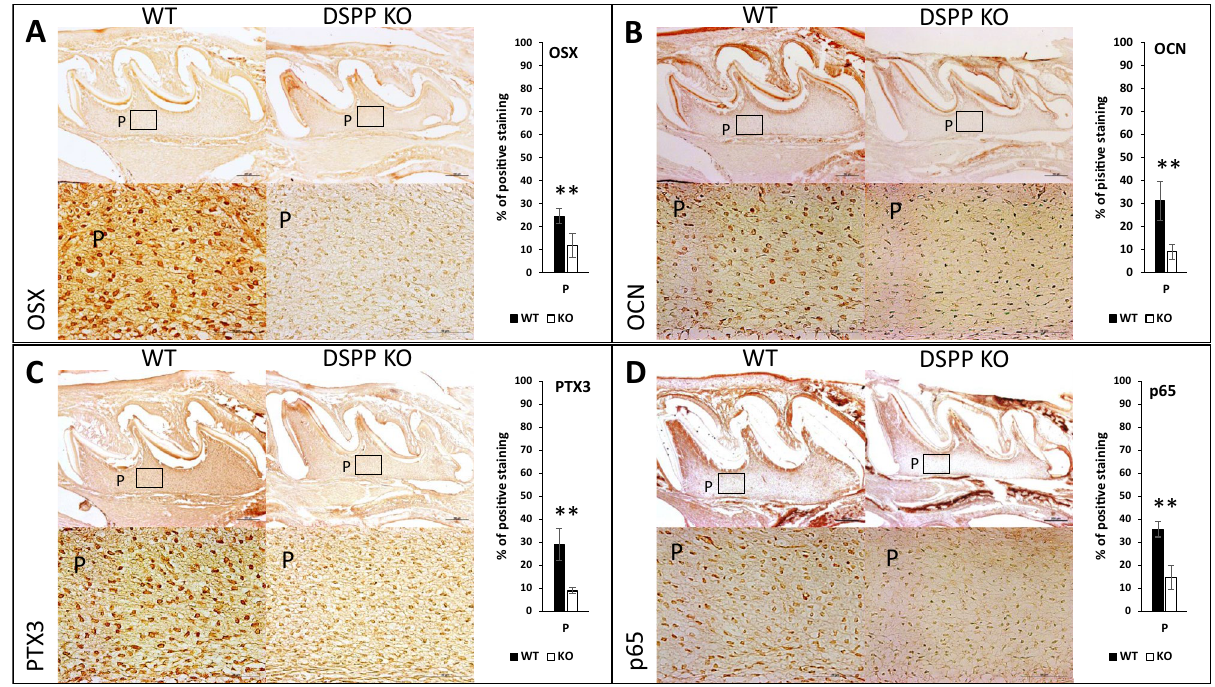
Figure 9. Expression of NF-κB targets in PN day 5 DSPP-KO and WT mice in the dentin-pulp complex. Expression of Osx ( A ), OCN ( B ), PTX3 ( C ) and p65 ( D ) in WT and DSPP KO are shown. Boxes marked have been magnified and the corresponding images showing staining in the pulp are shown in the bottom panel. Quantification of the immunohistochemical positive signals in the pulp are represented as bar graphs. Statistical significance **p < 0.01. P